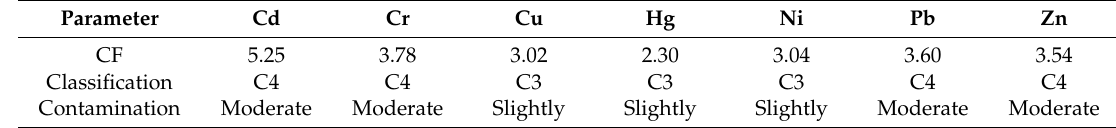
Table 4. The contamination factors (CFs) and contamination classification [33].